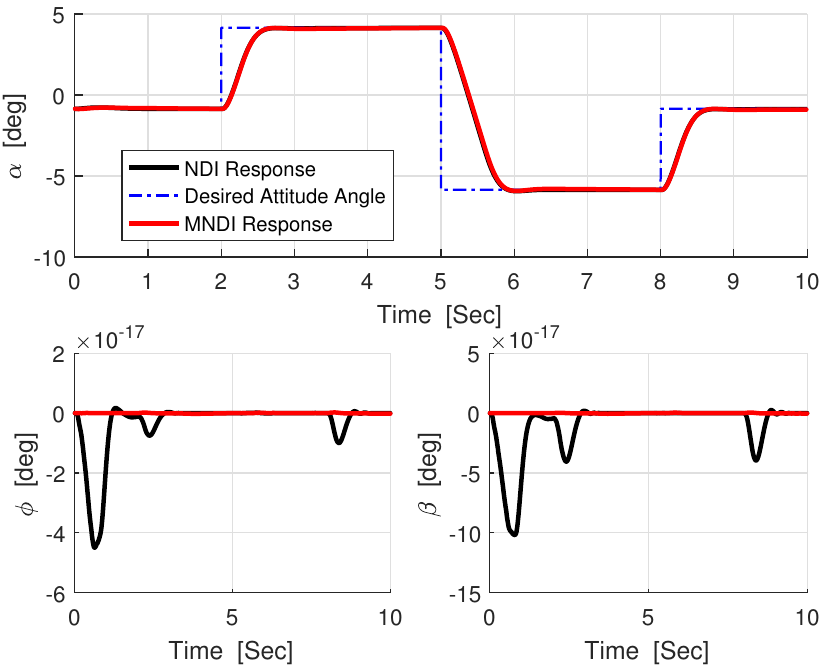
Figure 8. Attitudes response with NLDI and MNLDI with pitch angle excitation with wind disturbances.